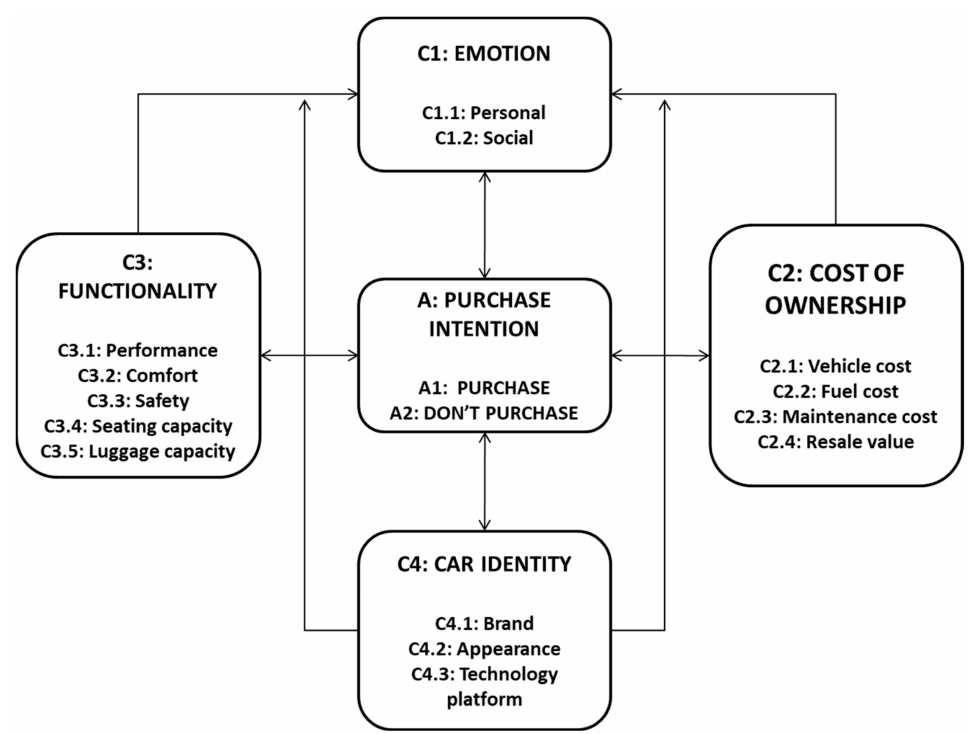
Figure 2. The ANP model for predicting consumers’ purchase intention towards electric